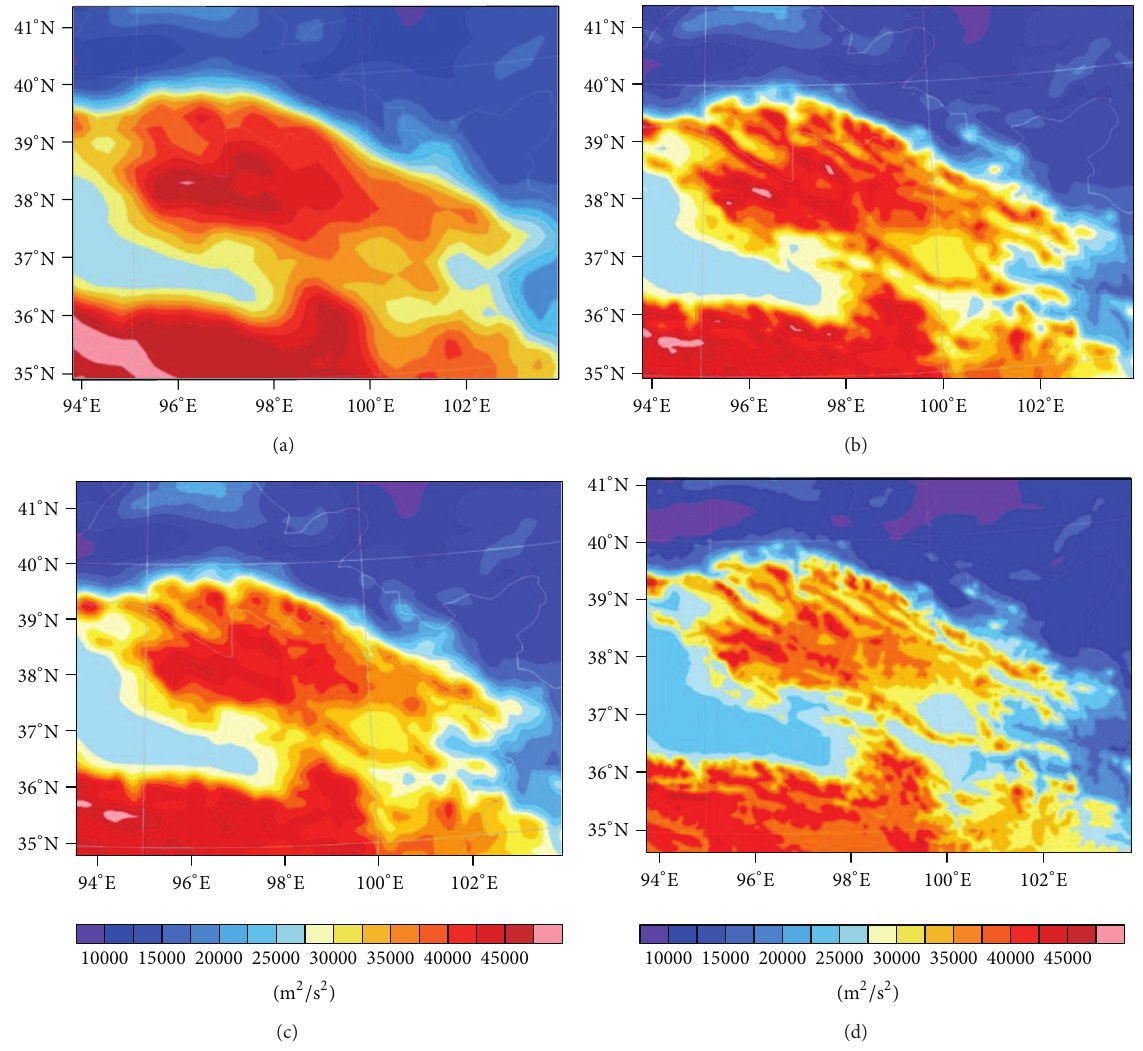
Figure 11: Geopotential height initial field for the CTRL and DA experiments: (a) CTRL; (b) DA-SAT; (c) DA-OBS; (d) DA-BOTH.